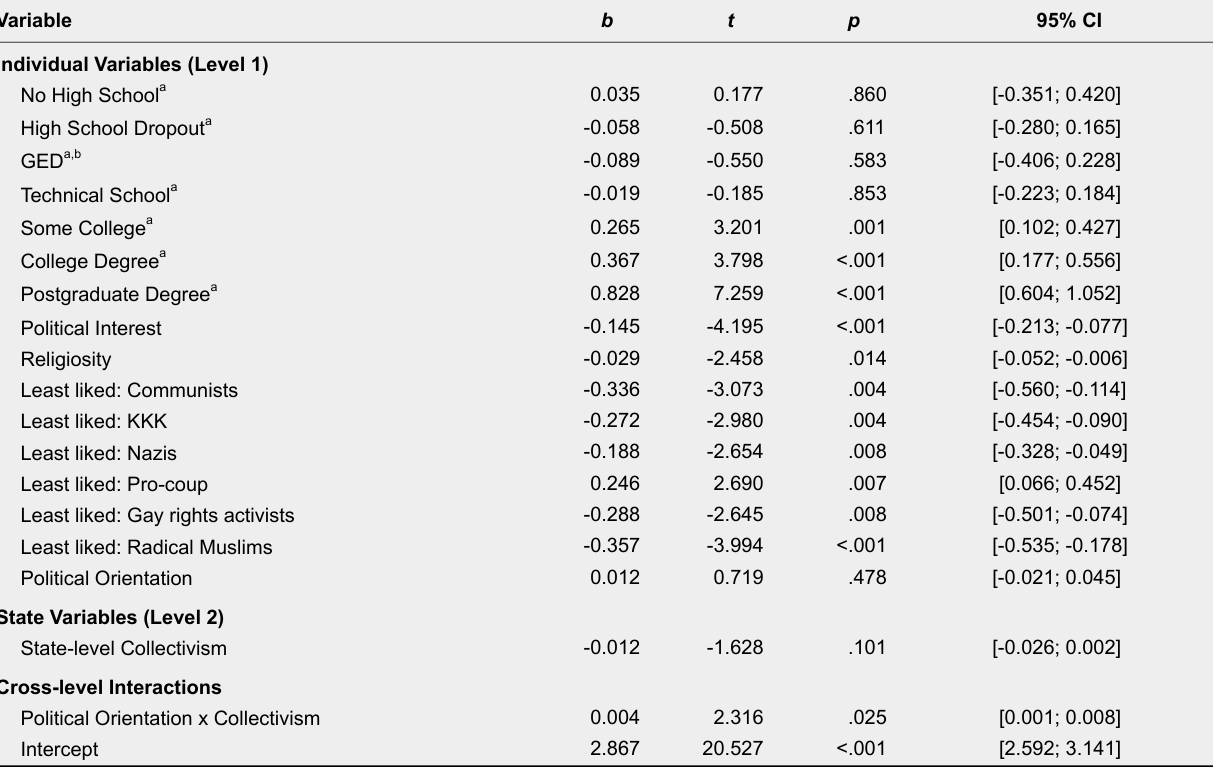
Estimated Coefficients and Significance for Variables in Multilevel Models Measuring Impact of Individualism/Collectivism and Political Orientation on Support for Free Speech (Study